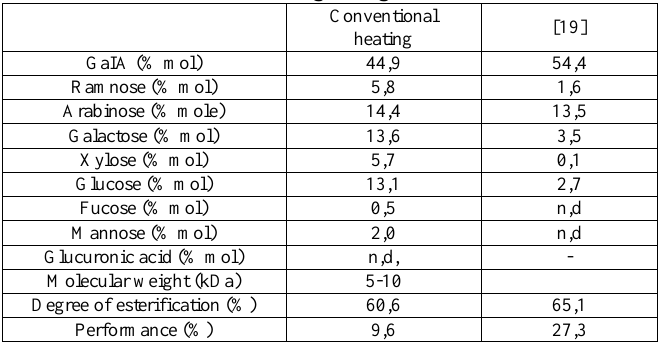
Table 1: Pectin quality obtained from shells of conventional heating orange.